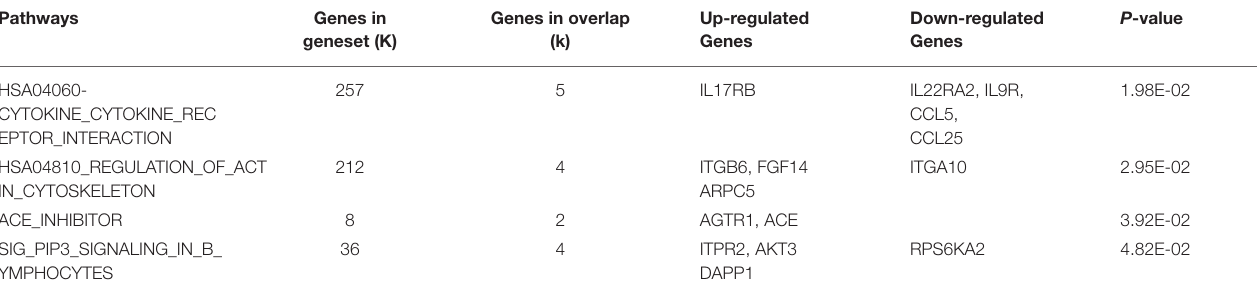
TABLE 3 | Analysis of the differential gene pathways of model group compared with the control group. Pathways